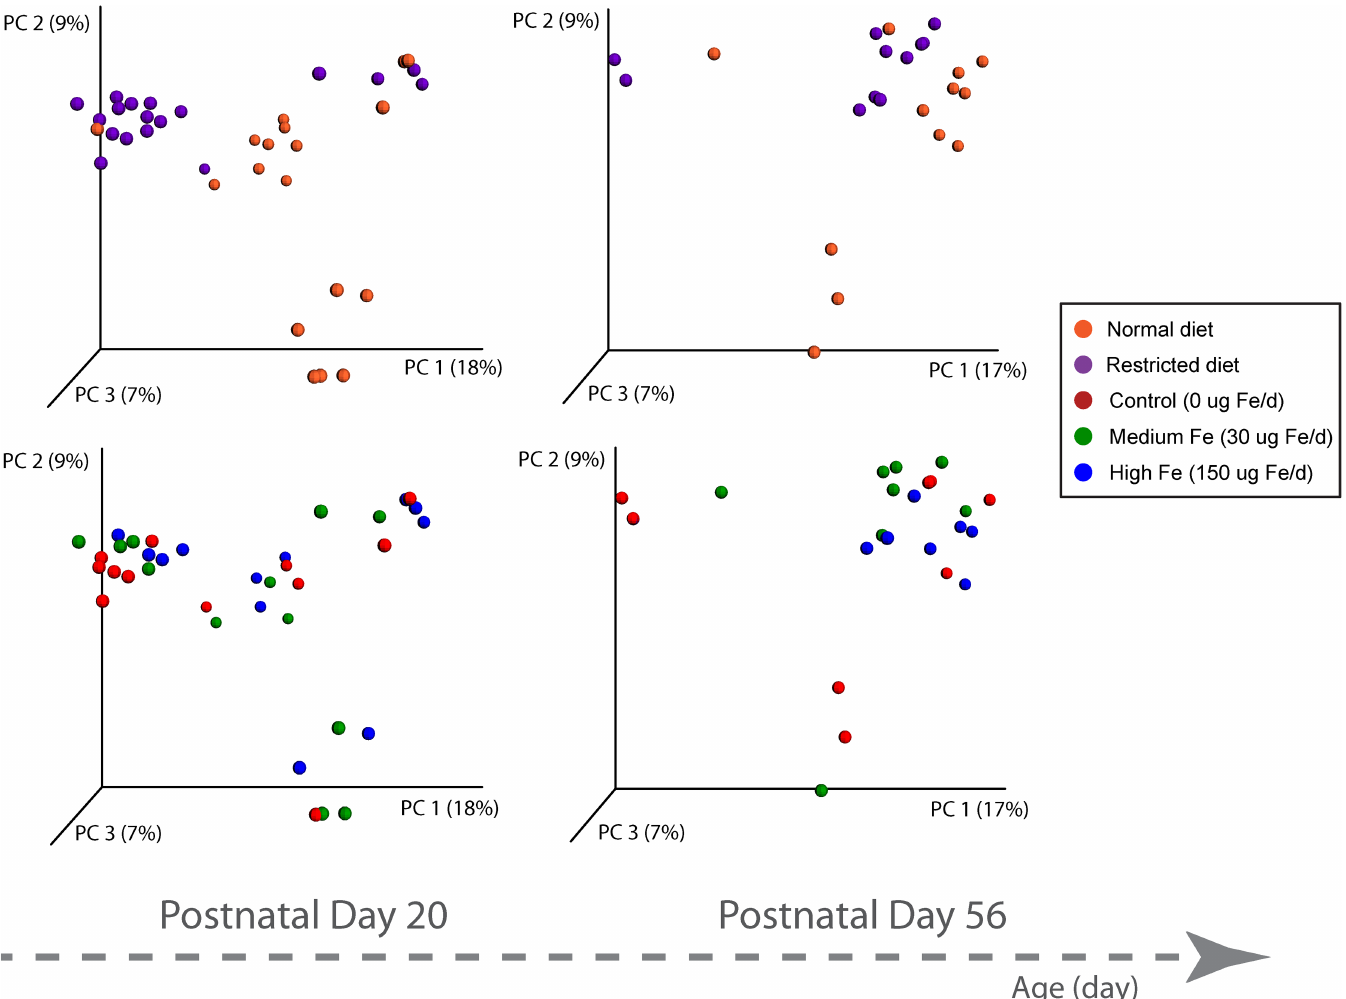
Fig 6. Principal coordinates analysis (PCoA) of 16s rRNA. PCoA of unweighted Unifrac distances of 16S rRNA sequencesdemonstrates clustering alongPC1 basedon diet (upper half of the figure) (purplerepresents restricted and orangeas normal)for day 20 and 56. Clusteringbasedon iron supplement (lower half of the figure) (0 μ g (Control), 30 μ g (medium), or 150 μ g (high)).